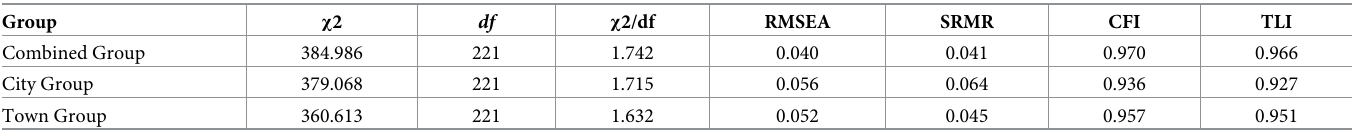
Table 7. Structural equation model indices.